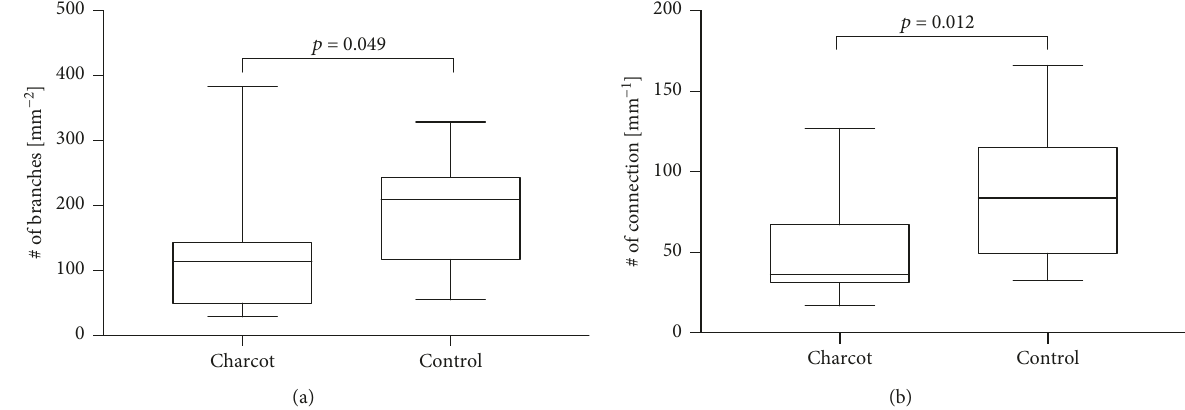
Figure 4: Corneal nerve branch density de fi ned as the number of branches per mm 2 ( p = 0 049 ) (a) and corneal nerve connecting points de fi ned as the number of nerve fi bres crossing area boundary ( p = 0 012 ) (b) in Charcot and control